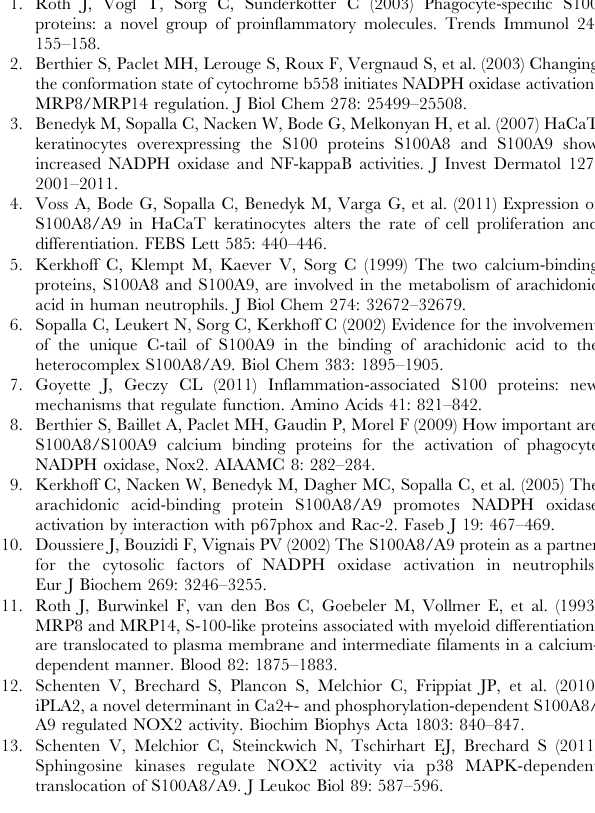
Table S1 Plasmid construction for protein expression.